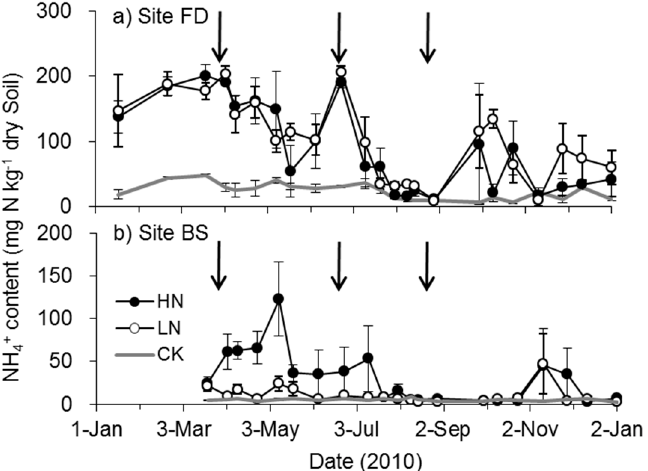
Figure 3. Seasonal dynamics of soil NH 4+ content (mg N kg − 1 ) across the sampling sites and treatments in 2010. ( a ) Fertilizer ditches; ( b ) Bare soil; Data points indicate the mean of the three replicates; error bars indicate the standard error (SE). Black arrows indicate nitrogen fertilizer applications.